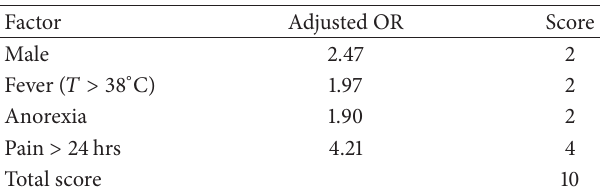
Table 6: Scores for predicting ruptured appendicitis in elderly